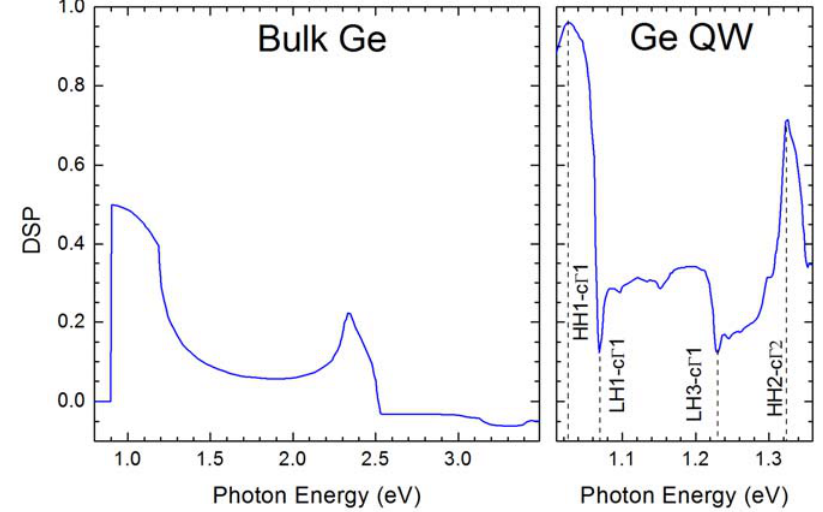
Figure 4. Degree of spin polarization (DSP) of conduction electrons optically excited in bulk Ge ( left panel [129]) and in a Ge QW heterostructure ( right panel [160]). Adapted with permission from [129], Copyright the American Physical Society, 2010. Adapted with permission from [160], Copyright the American Physical Society 2009.